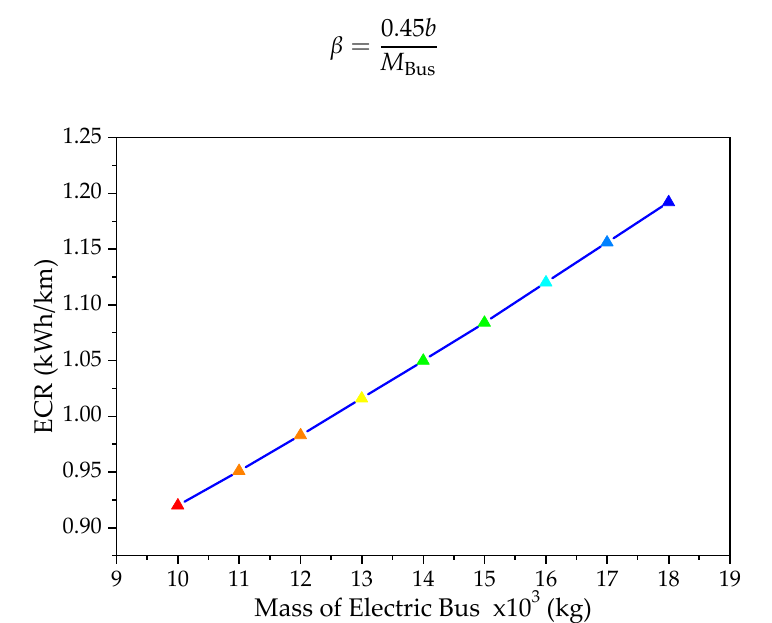
Figure 2. Relationship between energy consumption rate (ECR) and the mass of the electric bus.